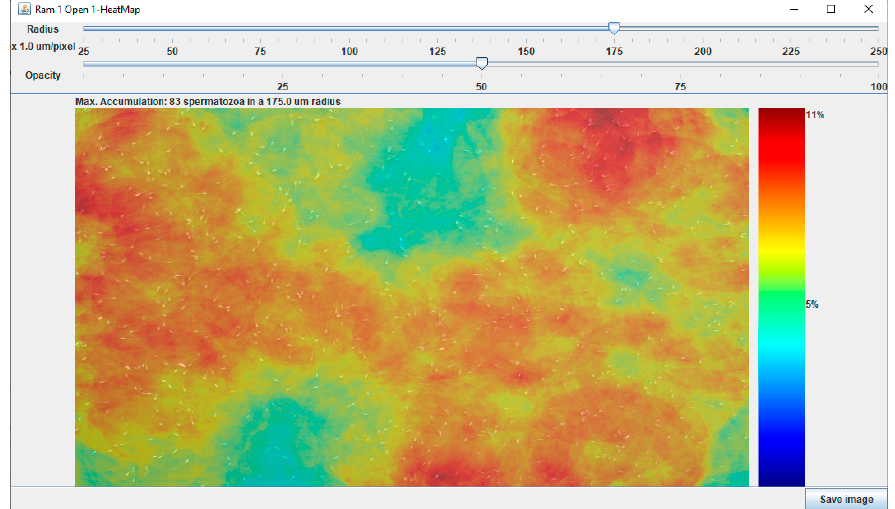
Figure 1. Heat map provided by the Chemotactic Sperm Accumulation Module, showing sperm accumulation. Right bar shows the Jet look up table (LUT). Cold and warm colors represent low and high accumulation values.